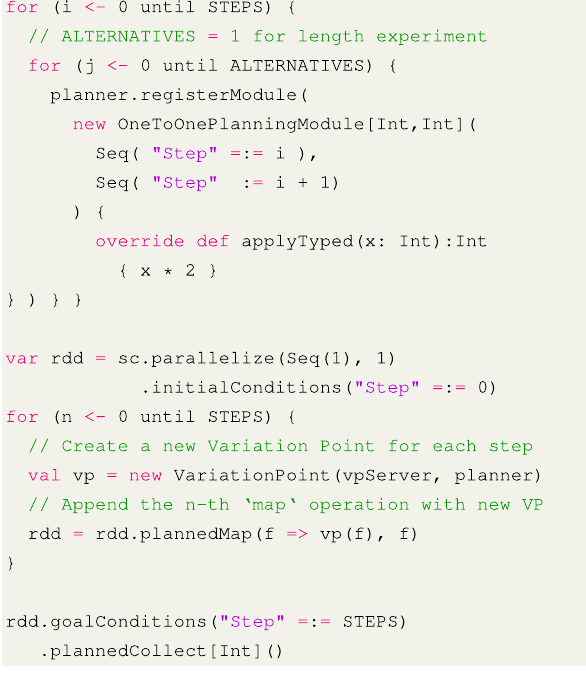
Frontiers in Big Data |